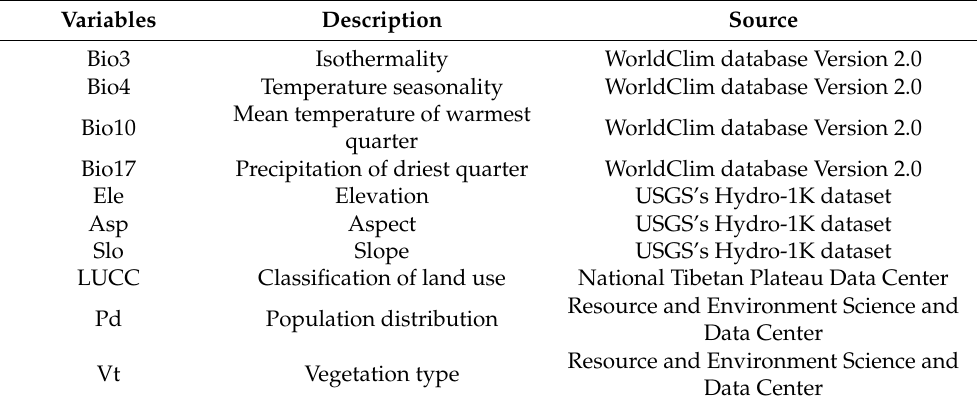
Table 1. Predictor variables for C. pictus and C. amherstiae and their data